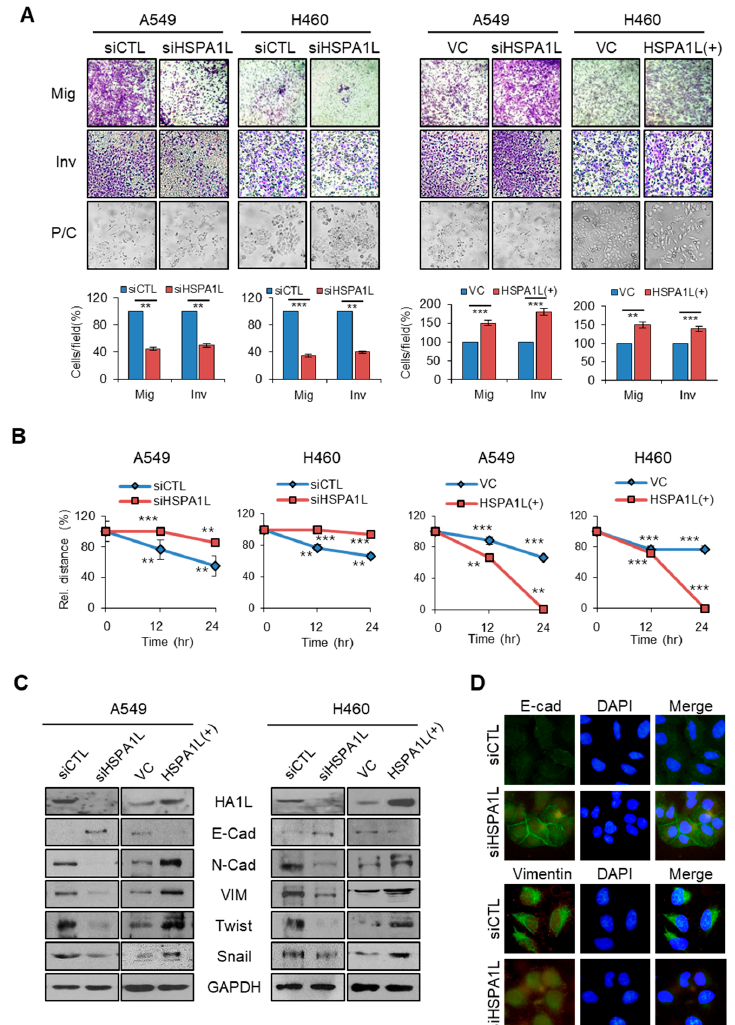
Figure 3. HSPA1L was involved in epithelial–mesenchymal transition (EMT) of lung cancer cells. ( A ) Migration (upper panel) and invasion (middle panel) assays of A549 and H460 cells transfected with the HSPA1L-targeted siRNA and pcDNA-HSPA1L expression vector. Cells in transwells 48 h after transfection. Cells were stained 24 h later and photographed under a phase-contrast (P/C) microscope. The stained cells were counted, and the relative number of cells per field was plotted. ( B ) Wound-healing assays of A549 and H460 lung cancer cells transfected with siRNA targeting the HSPA1L and pcDNA-HSPA1L expression vector. At each point in the assay, cells were photographed, wound size was determined, and the size relative to the initial size was plotted. ( C ) Western blot analysis of EMT markers, E-cadherin, N-cadherin, Vimentin, Twist, and Snail in A549 and H460 cells transfected with siRNA targeting the HSPA1L and pcDNA-HSPA1L expression vector. GAPDH was used as a loading control. ( D ) Immunocytochemistry analysis of E-cadherin and Vimentin after transfection with siRNA targeting the HSPA1L in A549 cells. Target molecules were probed using specific antibodies. Data represent the mean ± SD of three independent experiments using a two-tailed t-test. ** p < 0.01, *** p < 0.001.